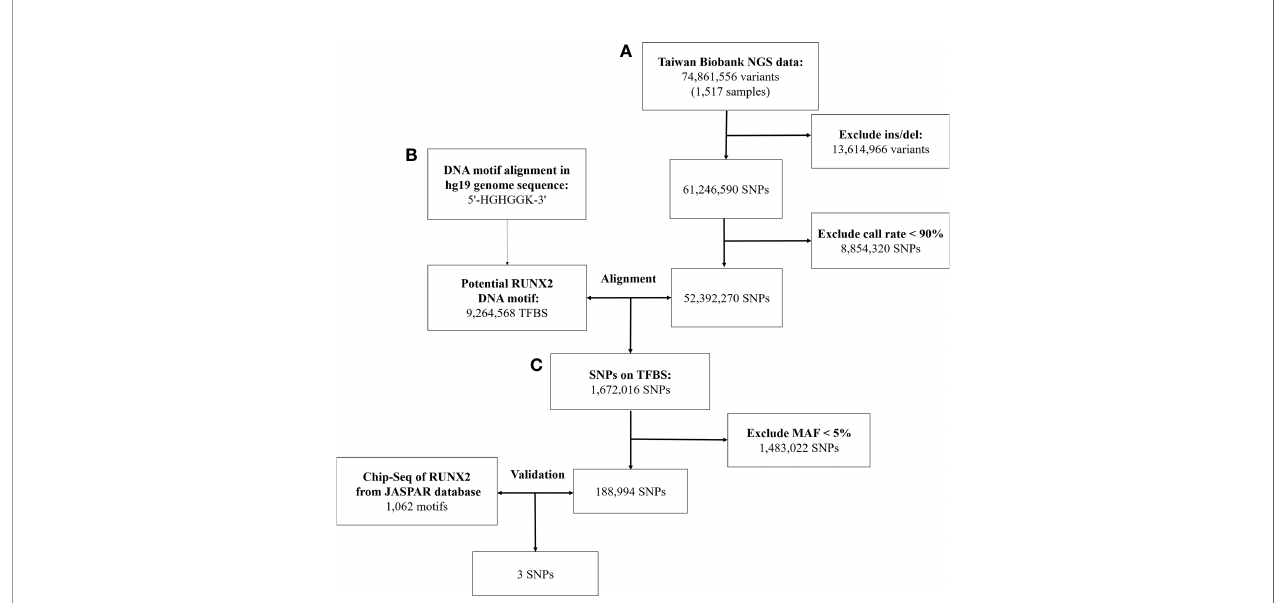
FIGURE 1 | Work fl ow of the stepwise approach of candidate binding site SNPs. (A) Screen the genetic variation in the genome of Taiwanese through quality control procedures. (B) Identify genetic variants that may affect RUNX2 binding motif through bioinformatics sequence alignment. (C) Chromatin immunoprecipitation sequencing (ChIP-Seq) to con fi rm that these genetic variants will bind to these binding motifs. NGS, next-generation sequencing; SNP, single-nucleotide polymorphism; Ins/sel, insertion/deletion; TFBS, Transcription factor binding site; MAF, minor allele frequency.